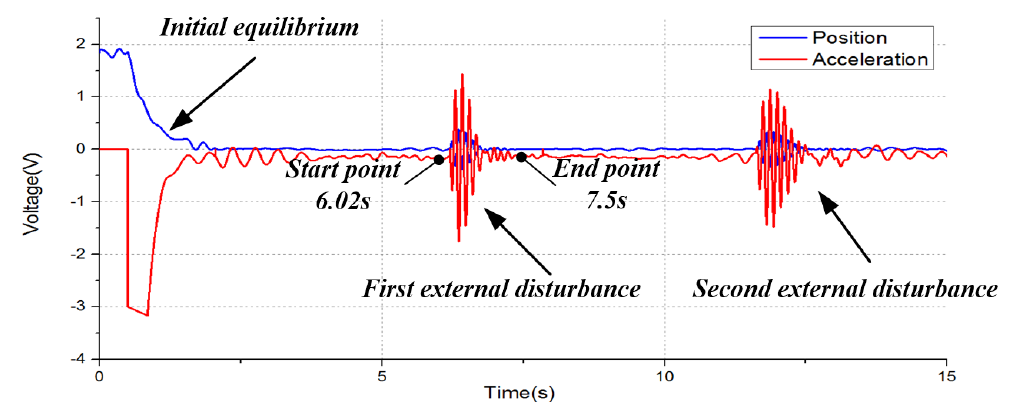
Figure 11. The results of the control capability.